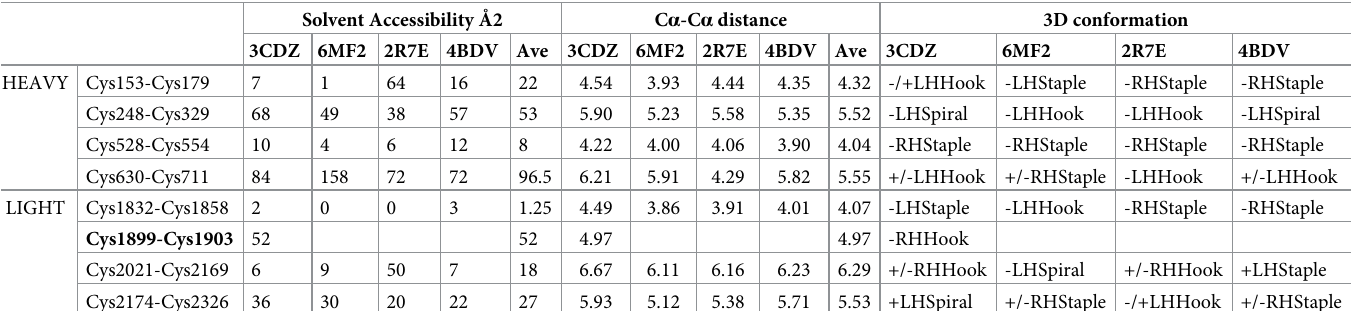
Table 1. Structural parameters of disulfide bonds using online prediction analysis. Four published FVIII structures were evaluated in parallel using the UNSW DSB prediction tool [58]. Allosteric disulfide bonds tend to be solvent accessible and have short alpha carbon distances. Stable structural disulphide bonds tend to have a -LHspiral conformation; these have the most common DSB conformation and have the lowest dihedral strain